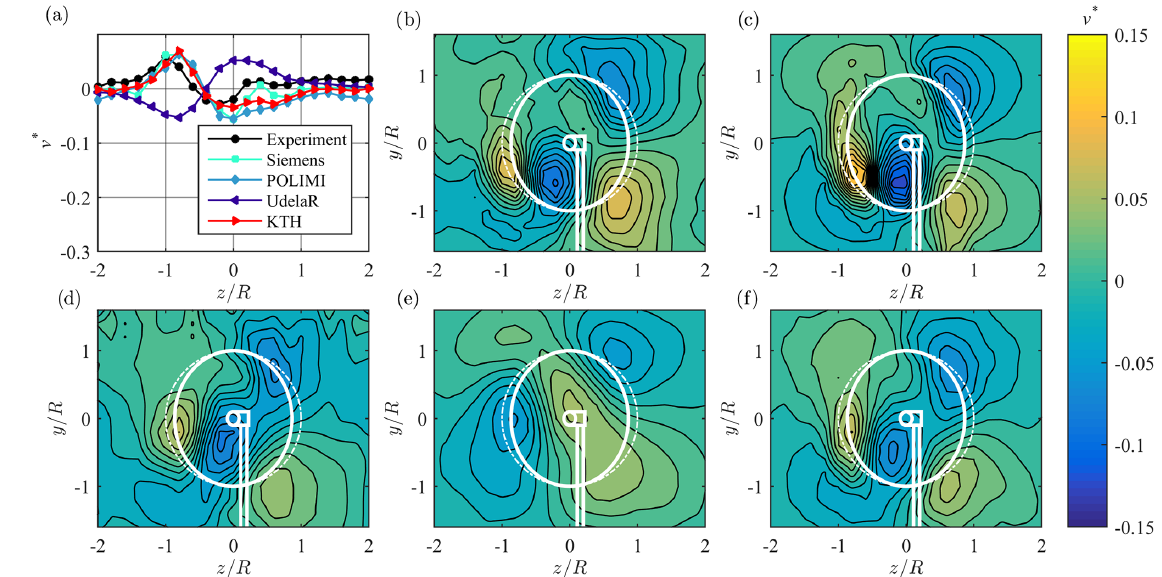
Figure 8. (a) Line plot at hub height and (b–f) contour plots for normalized vertical mean velocity v ∗ in the wake 3 D behind turbine LARS1, from (b) experiments, (c) Siemens, (d) POLIMI, (e) UdelaR, and (f) KTH. The white lines represent the turbine rotor, nacelle, and tower; solid lines γ = 30 ◦ ; dashed lines γ = 0 ◦